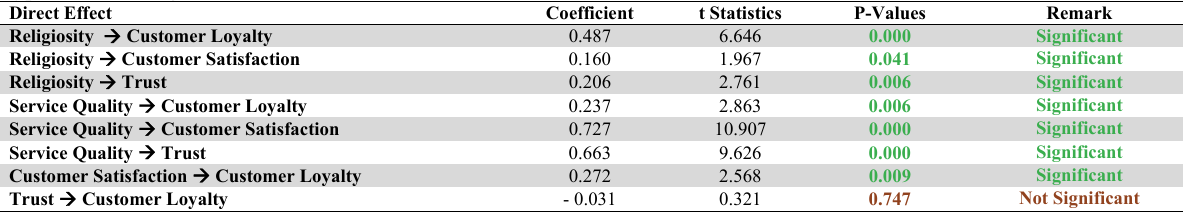
Hypothesis Testing of Direct Effects